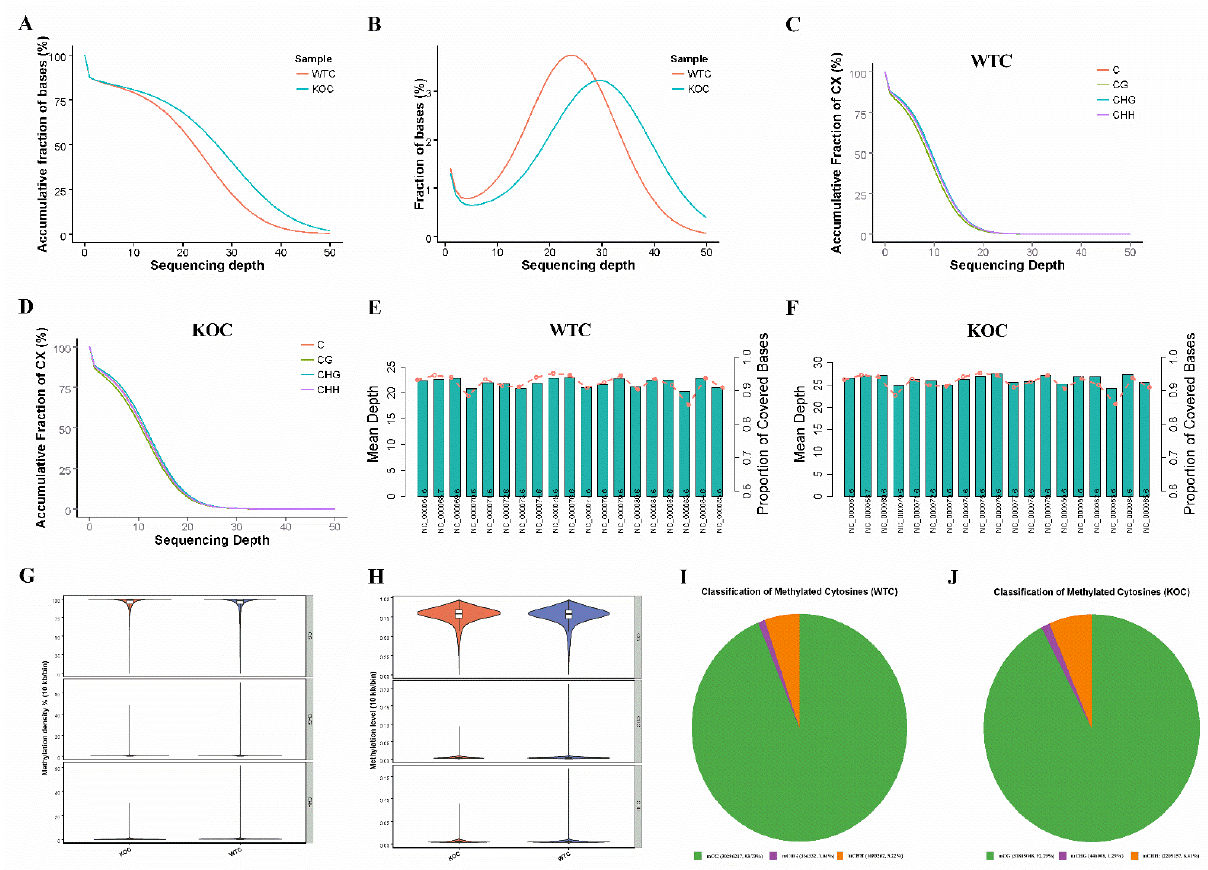
Figure 2. Whole-Genome Bisulfite Sequencing of liver sample in WT and KO mice . ( A ) The cumulative genome distribution in the liver of WT and KO mice . ( B ) The genome coverage of the liver in WT and KO mice . ( C , D ) The cumulative coverage of C sites in each context. ( E , F ) Distribution of WGBS reads on chromosomes. ( G ) Whole-genome DNA methylation density in each context. ( H ) The mean DNA methylation level in each context. ( I , J ) The ratio of methylated cytosines in each context (green: mCG, purple: mCHG, and orange: mCHH).